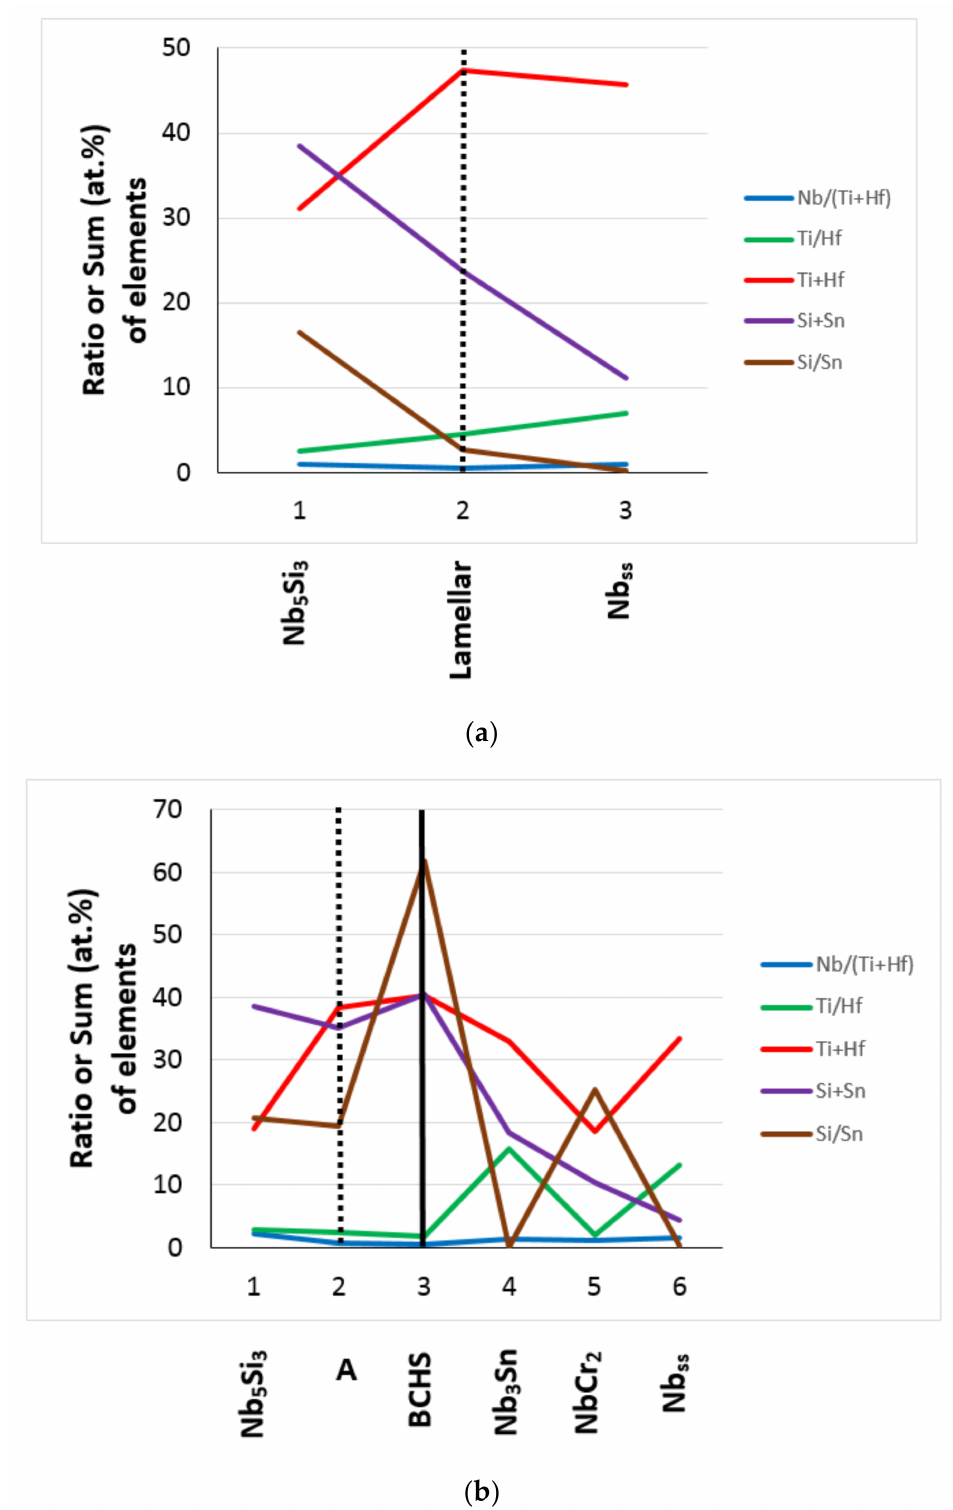
Figure 20. Ratios or sums of solutes based on average solute concentrations from Nb 5 Si 3 towards the Nb ss ( a ) for the lamellar microstructure in EZ2-AC and ( b ) the microstructure A in EZ6-HT2. In ( b ), BCHS = bright contrast hexagonal silicide. The data in this figure is not from a line scan; instead, it is quantitative analysis data from microstructures like those in the Figures 2 and 8. The A15-Nb 3 X is shown as Nb 3